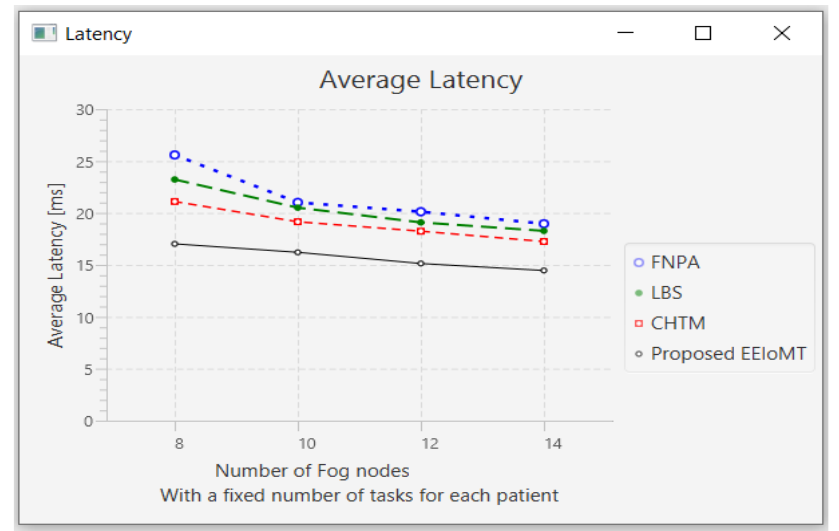
Figure 12. Average latency comparison when changing the number of fog nodes.